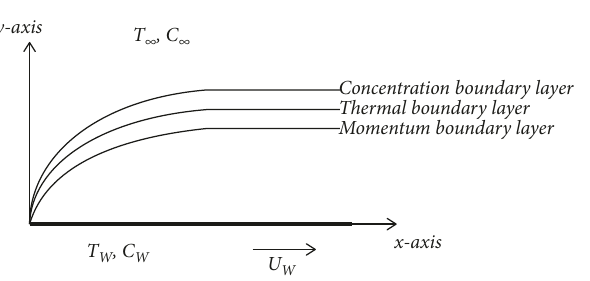
Figure 1: The geometry of the